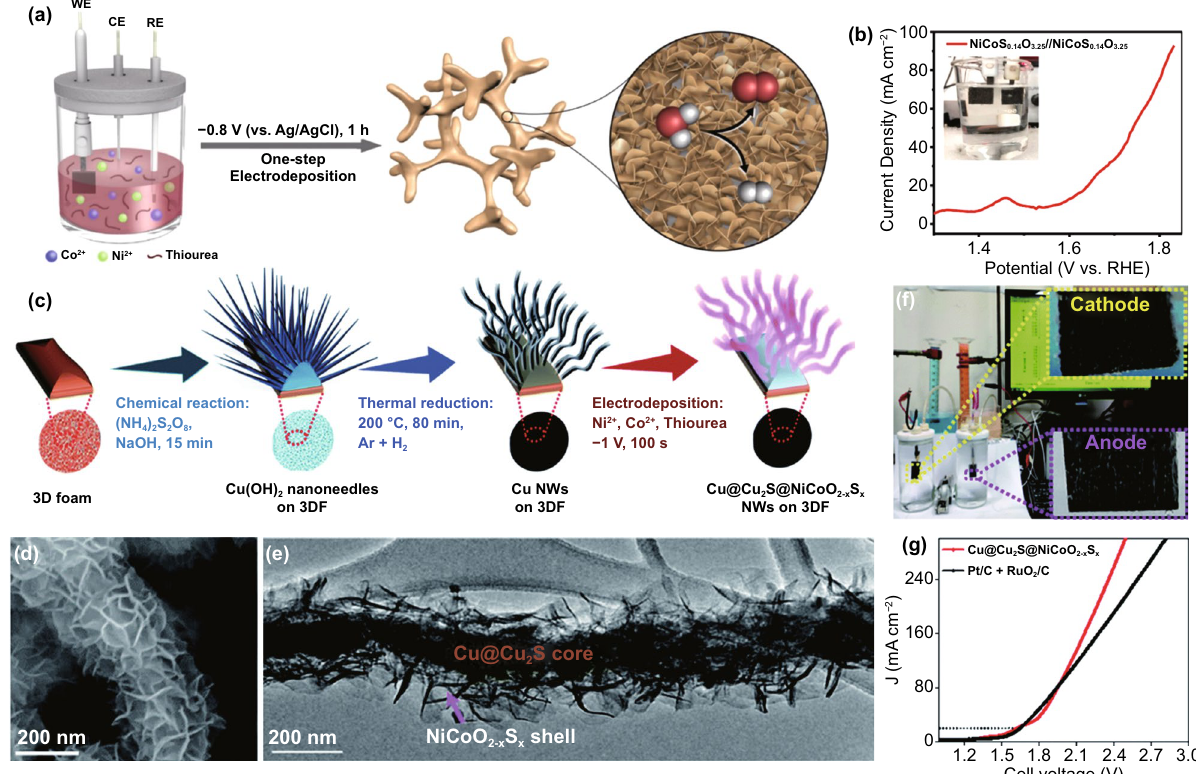
Fig. 9 a Schematic illustration of the synthesis of 3D NiCoSxOy nanosheet arrays on Ni foam, and the application as OER and HER catalysts for overall water-splitting, b two electrode OER polarization curves (without iR compensation) of NiCoS 0.14 O 3.25 NSs/NF//NiCoS 0.14 O 3.25 NSs/ NF at a scan rate of 1 mV s −1 . Inset: A photograph of the all Ni–Co nanosheets arrays-based electrolyzer. Reprinted with permission from Ref. [136]. Copyright Year 2018. Elsevier. c Schematic illustration of the Cu@Cu 2 S@NiCoO 2− x S x NW fabrication, d FE-SEM and e TEM image images of Cu@Cu 2 S@NiCoO 2− x S x NWs on 3DF, f the fabrication of an electrolyzer based on cathodic and anodic Cu@Cu 2 S@NiCoO 2− x S x NW electrodes, g LSV measurement for the overall water-splitting performance of the electrolyzer devices based on Cu@Cu 2 S@NiCoO 2− x S x NW electrodes and (Pt/C + RuO 2 /C) electrodes. Reprinted with permission from Ref. [137]. Copyright Year 2020. Royal Society of